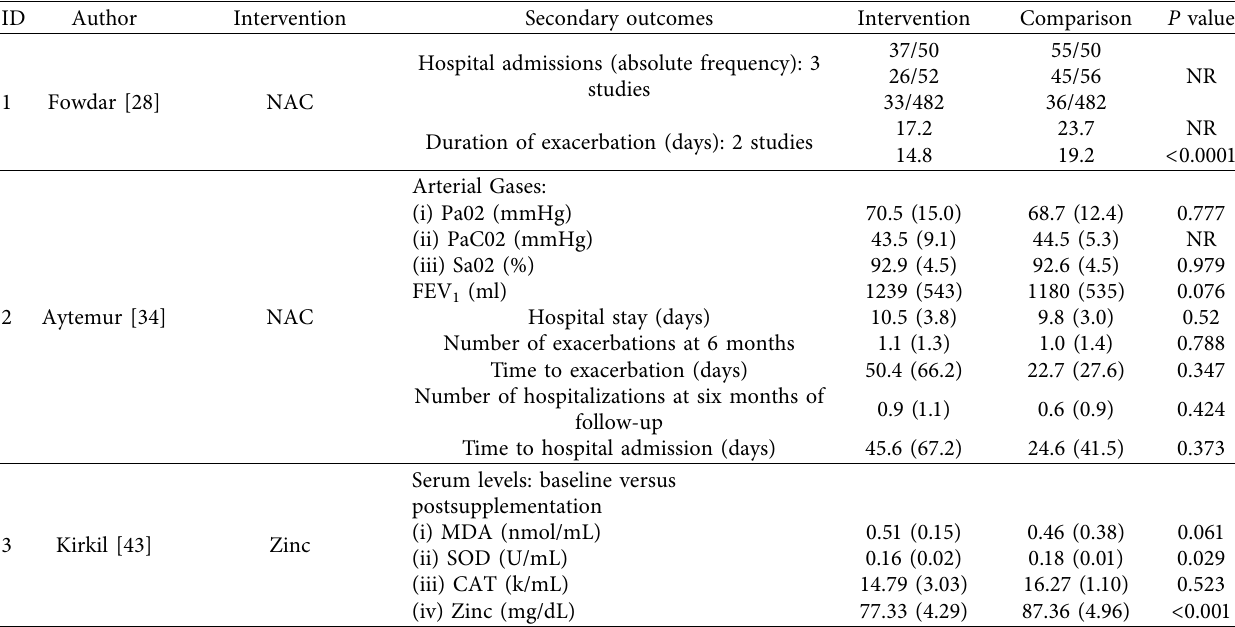
Table 3: Type of intervention and secondary outcomes